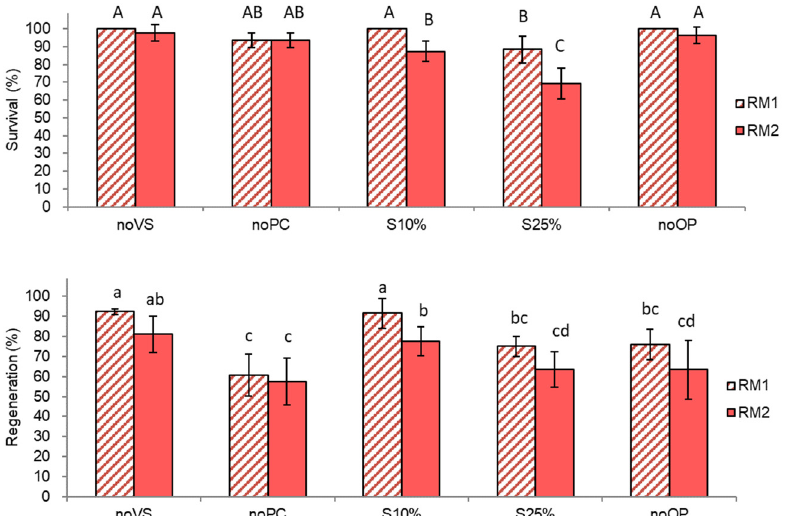
Figure 2. Effect of individual pre-LN protocol steps (preculture, osmoprotection, cryoprotection) and initial (first 5 days) regrowth on ammonium-free (RM1) or ammonium–containing (RM2) medium on survival and regeneration of Pogostemon yatabeanus shoot tips in the droplet-vitrification procedure. Shoot tips were cryoprotected but not cryopreserved. Treatment conditions are listed in the table in Section 4.2. (LNC).